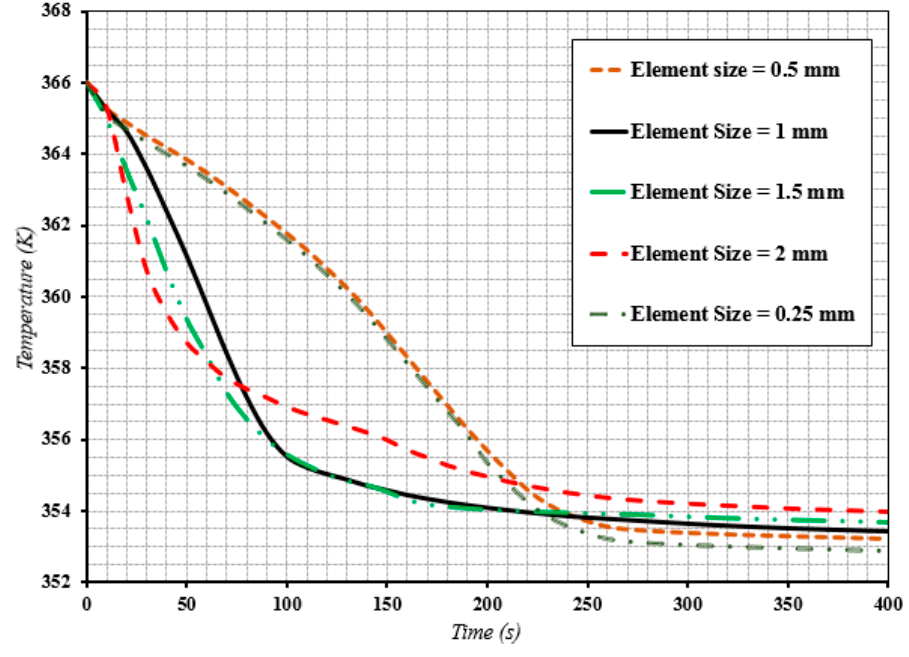
Figure 2. The mesh independency investigation.